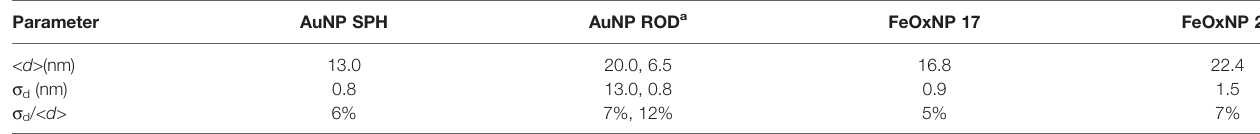
TABLE 1 | NP morphology.